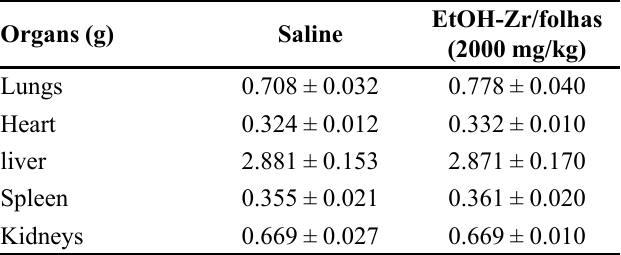
TABLE II - Effect of EEtOH-Zr/leaves (2,000 mg/kg, v.o.) on mean relative organ weight (%) in male rats.